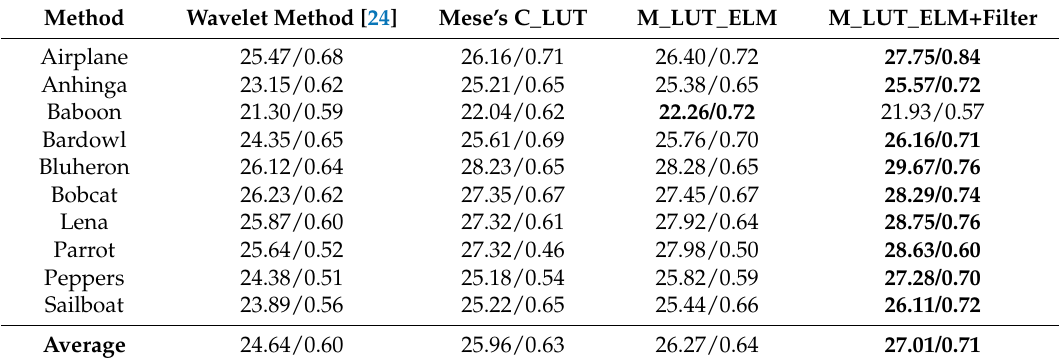
Table 3. Performance comparison of the proposed method with other methods